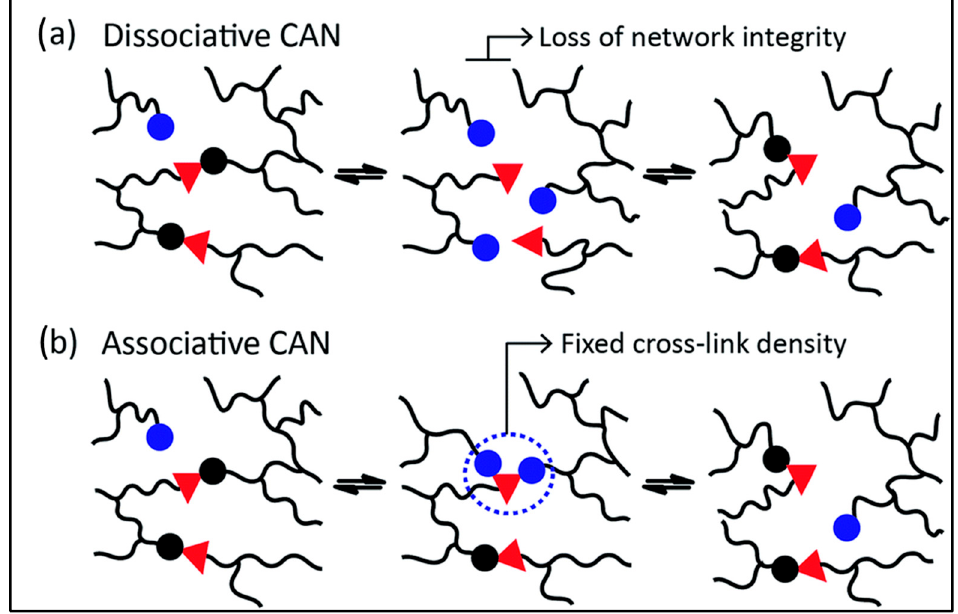
Figure 2. Recyclable mechanism of dynamic covalent adaptable networks (DCANs) [Reproduced with permission from Du Prez et al.; published by RSC, 2016] [21]. Blue and black dots, red triangles are used as active functional groups that can react each other at different conditions.